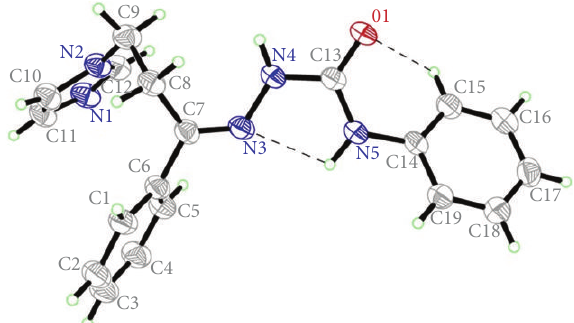
Figure 2: ORTEP diagram of the title compound 4 drawn at 50% ellipsoids for nonhydrogen atoms.